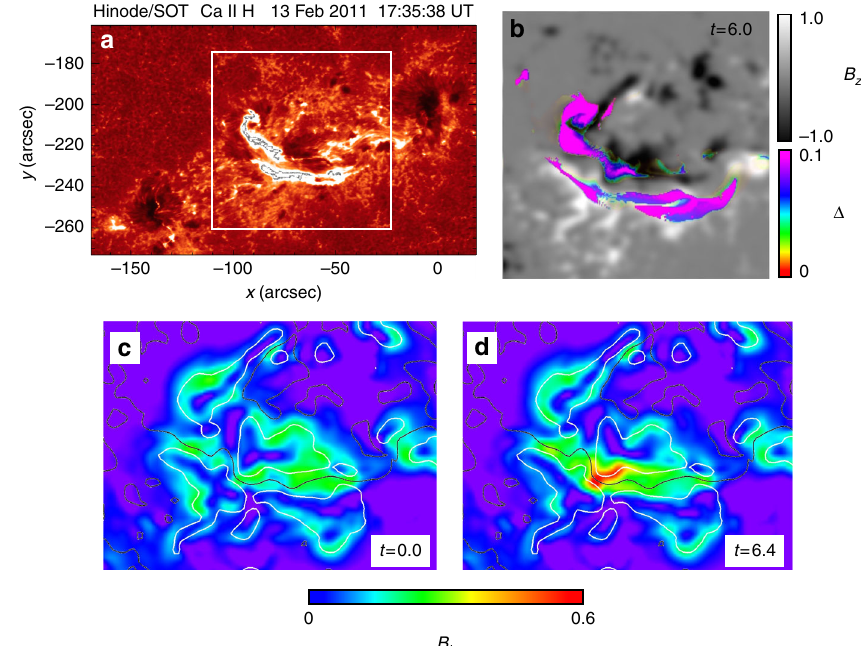
Fig. 5 Comparison of simulation results with observations. a Flare ribbons during M6.6 solar fl are, observed by Hinode at 17:35 UT on 2011 February 13. The intensity scale is 0 – 2000 DN. b Synthetic fl are ribbons measured from total displacement of the fi eld line footpoints 27 superimposed on B z distribution. The area corresponds to one surrounded by white square in a . c , d B h distributions obtained from simulation, just prior and during the eruption, respectively. Black and white lines correspond to polarity inversion line and contour of | B z | =